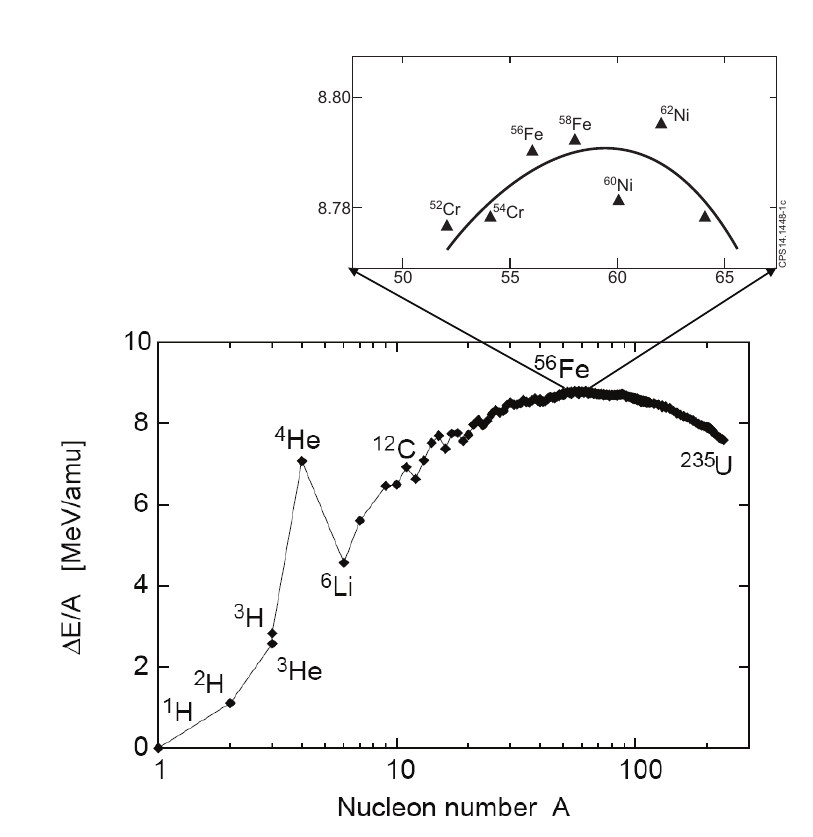
Fig. 1. – Binding energy per nucleon vs. atomic mass number showing the maximum in the curve reached for 62 Ni. Note the exceptionally large binding energy of the 4 He nucleus among the light nuclei. An approximate indication is given for the difference in binding energy per nucleon in fusion reactions of light nuclides with 4 He as one of the reaction products ( ∼ 5 MeV/nucleon) and fission of 235 U ( ∼ 0 . 9 MeV/nucleon). The exact numbers for the mass defects of selected nuclides with mass numbers up to 20 can be found in table